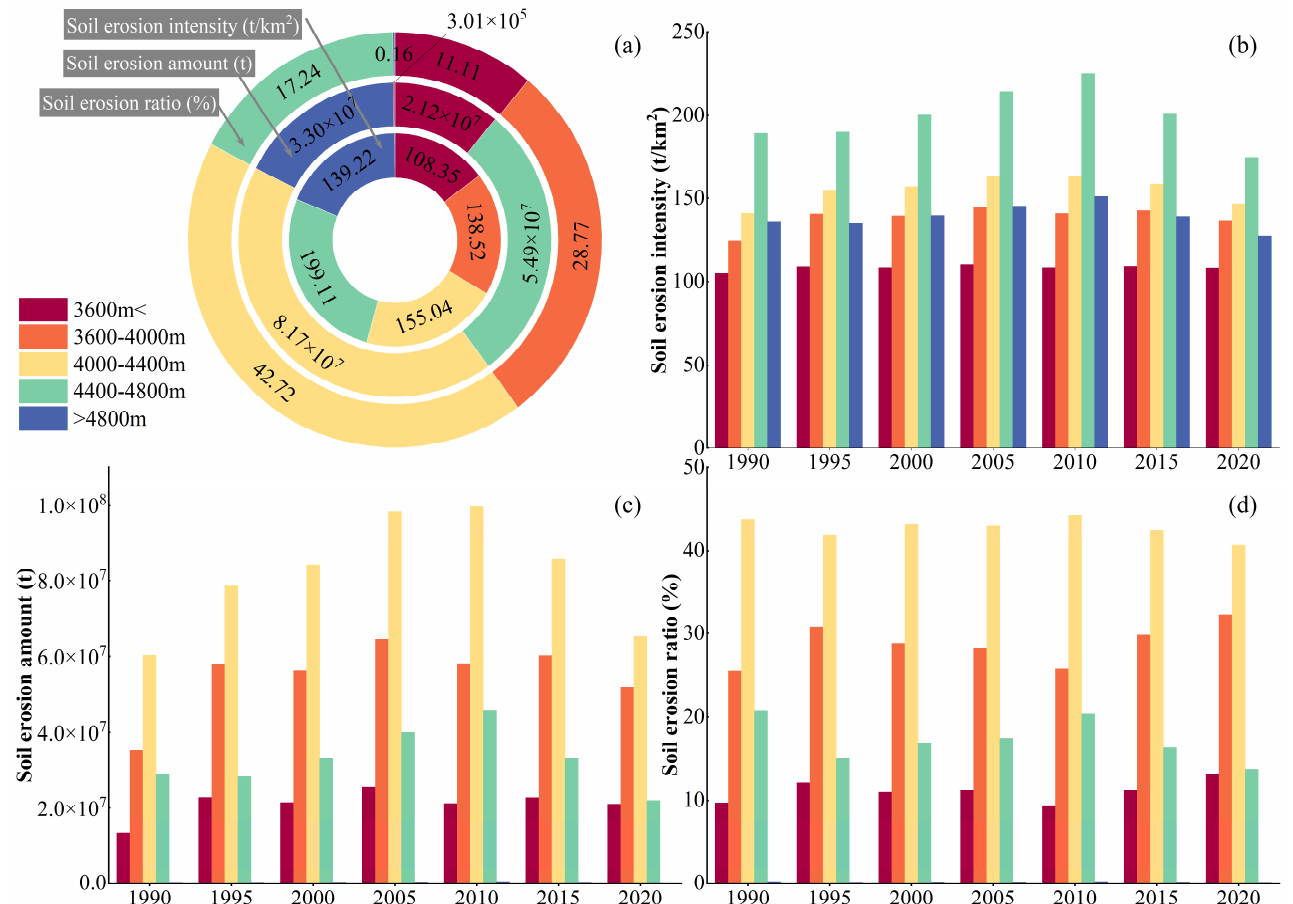
Figure 9. SE characteristics at different altitudes in the QLB. The average value of SEI for many years ( a ); the SEI from 1990 to 2020 ( b ); the SEA from 1990 to 2020 ( c ); the SER from 1990 to 2020 ( d